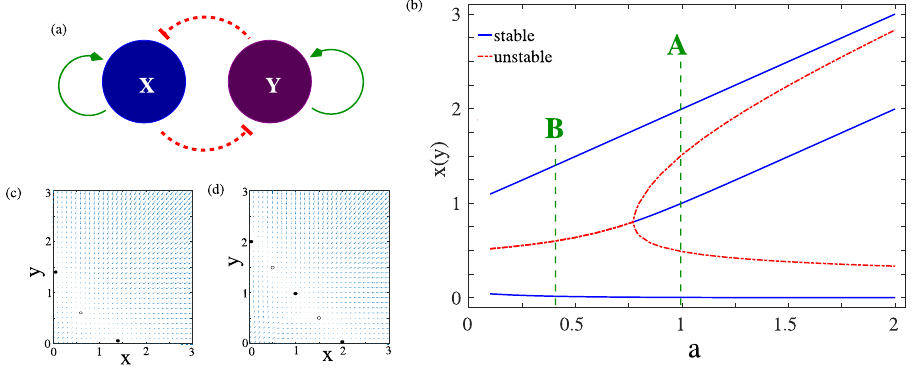
Figure 1. ( a ) A schematic of gene regulatory network. The two transcription factors X and Y are self-activating, and mutually inhibiting; ( b ) The bifurcation diagram of the non-delayed system of equations Eq. 1. The dashed green lines correspond to the two values of the feedback parameter a that were analysed in subsequent section. The other parameters were fixed at a 0 = 0.5, b = 1.0, k = 1.0, n = 4, and S = 0.5. The velocity vector plots in the ( x , y ) plane for these two points are shown in ( c ) Regime B and ( d ) Regime